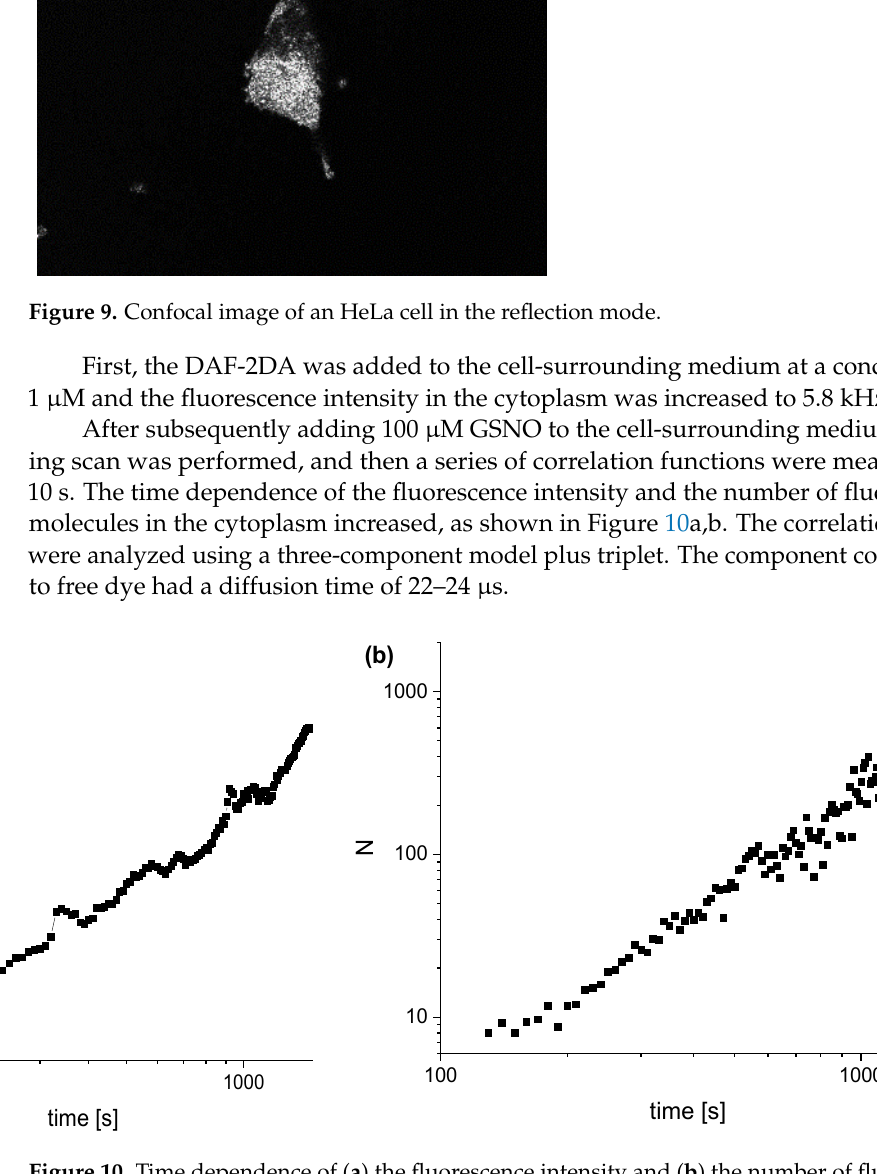
Figure 10. Time dependence of ( a ) the fluorescence intensity and ( b ) the number of fluorescing dye molecules measured in the HeLa cytoplasm after adding GSNO to the DAF-2 containing HeLa cells. GSNO was added approximately 30 min after adding the DAF-2DA. Based on our measurements in the HUVEC cells, we can assume that the dye concentration in the